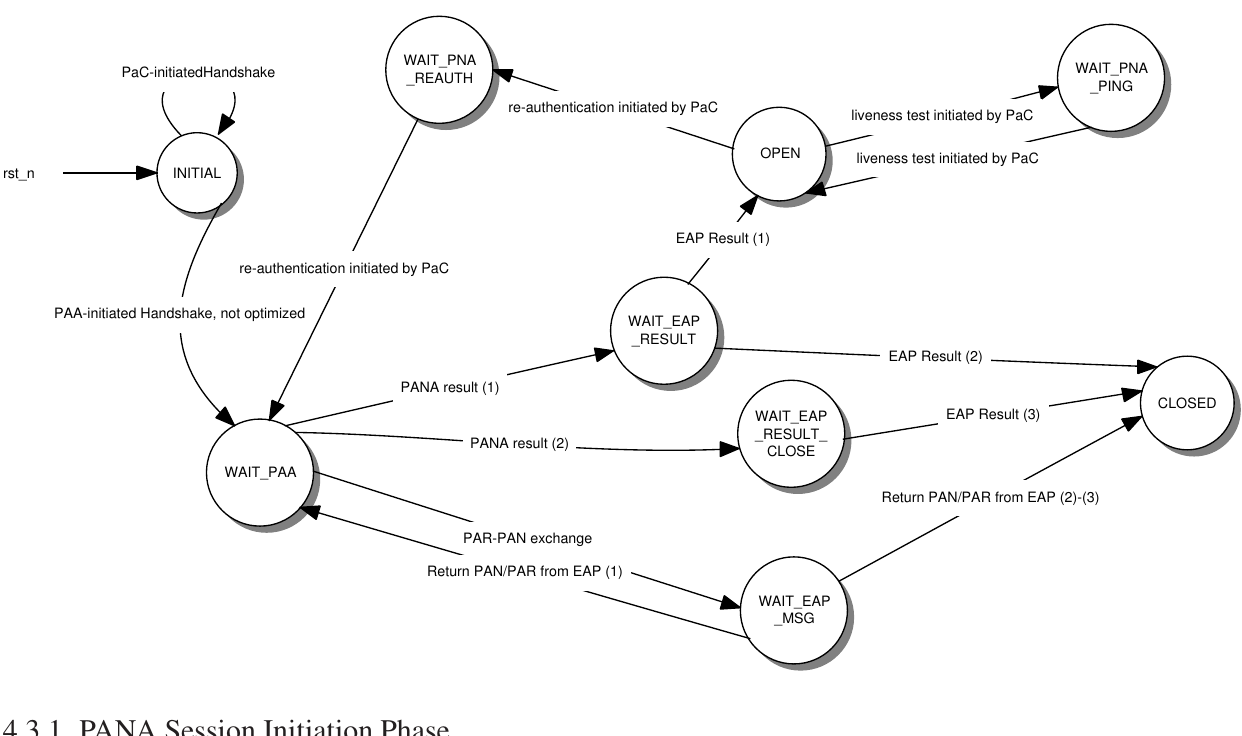
Figure 5. PANA light-weight state